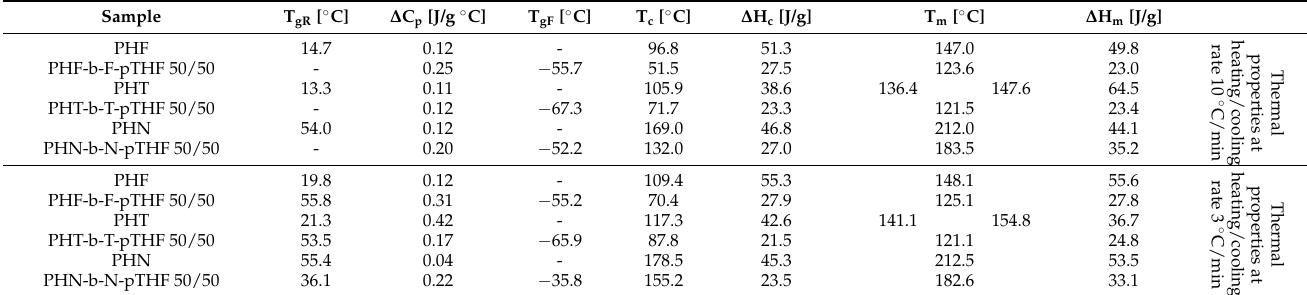
Table 4. Thermal properties determined from cooling and 2nd heating thermograms for synthesized polyesters and copolymers. Sample